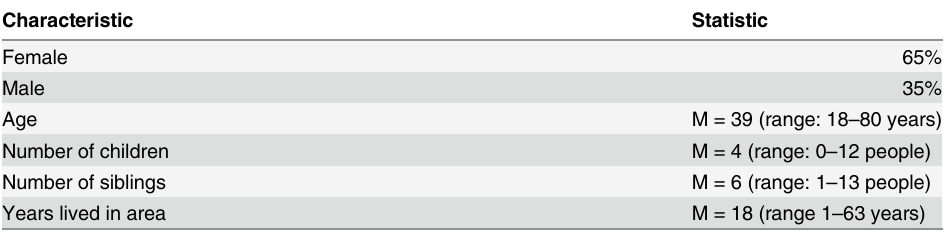
Table 2. Descriptive statistics based on interviews (n = 88) with Torotorofotsy, Madagascar residents, May 2014. Characteristic Statistic Female